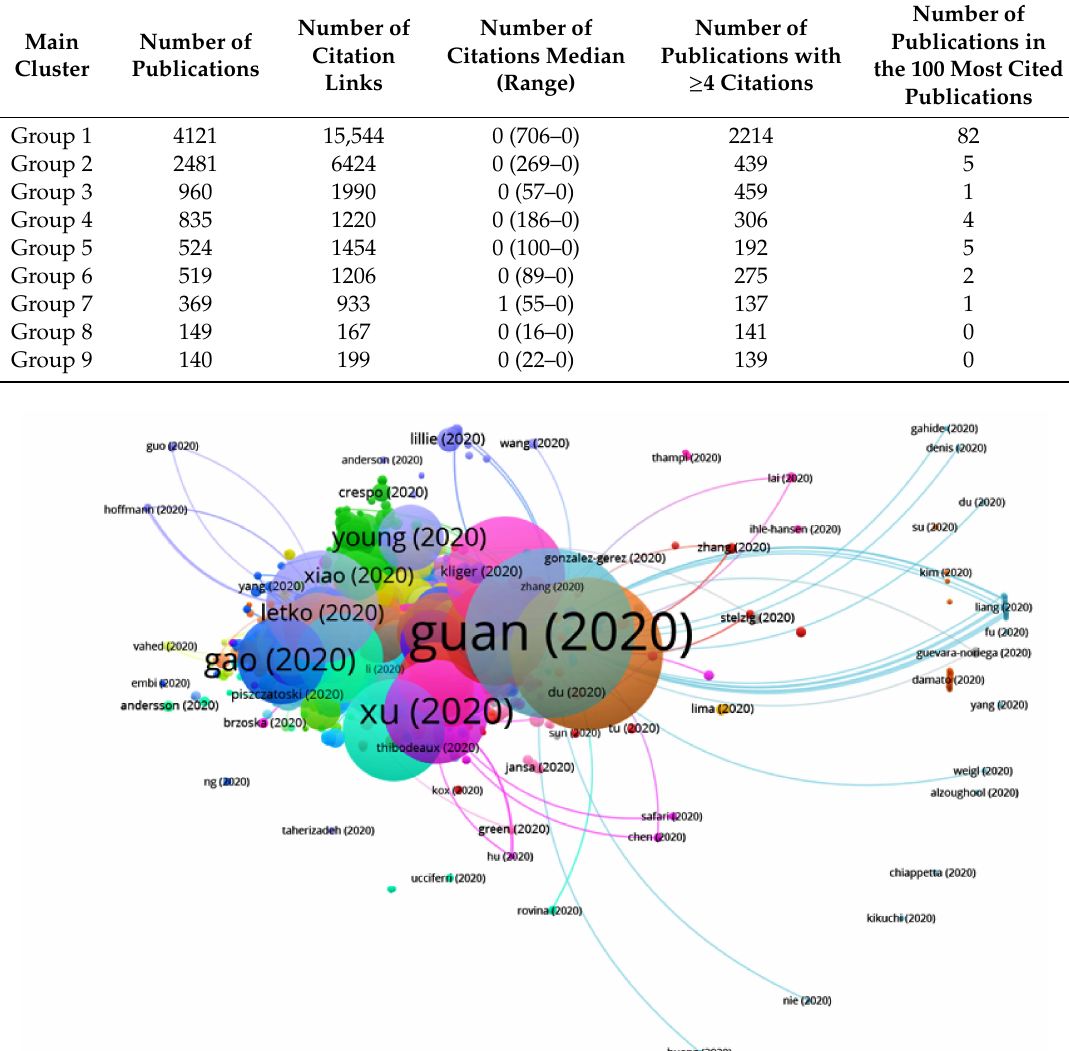
Table 4. Information on the citation network of the 9 main groups.